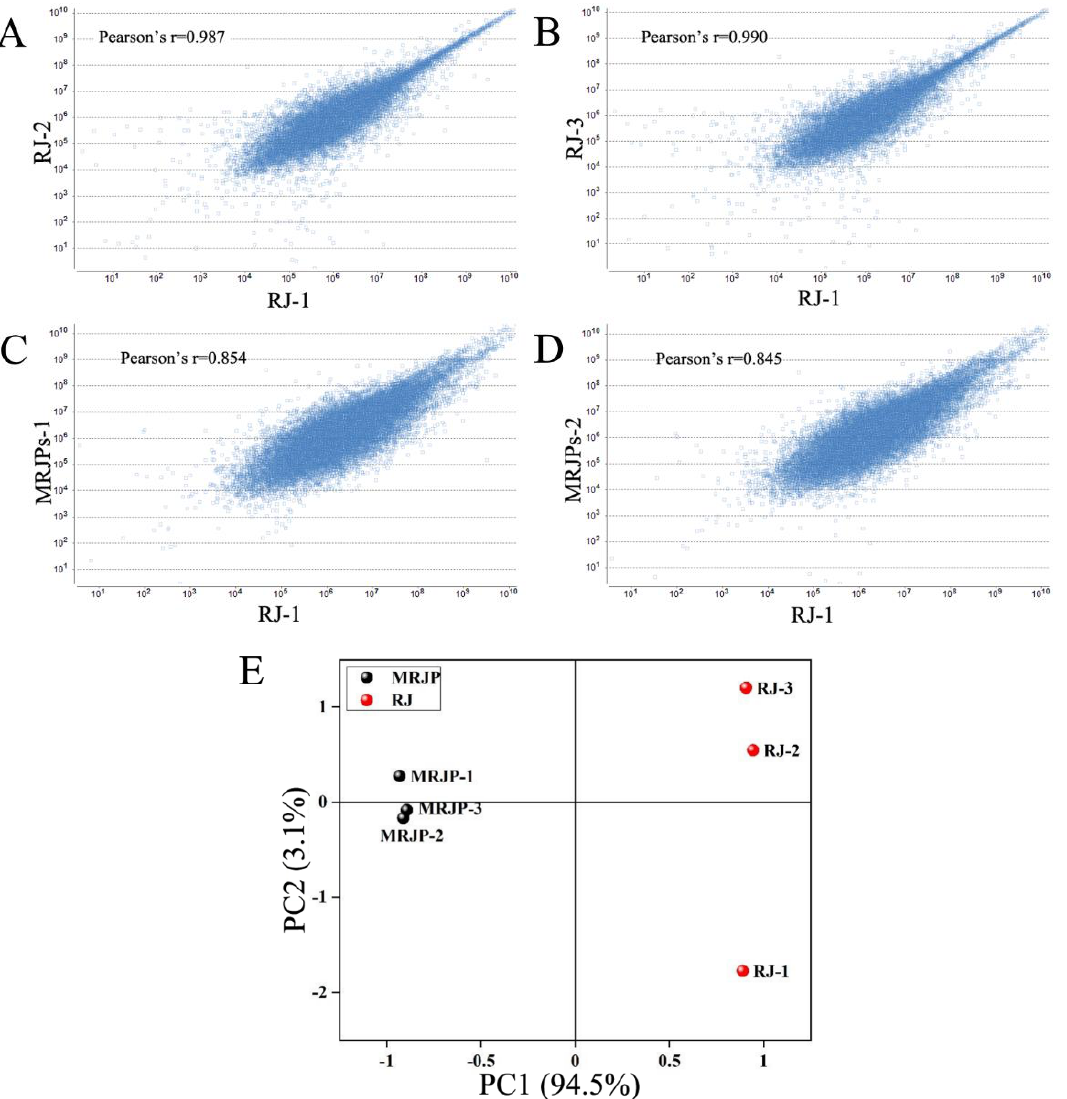
Figure 1. Pearson correlation coefficient and principal component analysis between the royal jelly and MRJPs with three times repeated data. ( A ) Pearson correlation coefficient between RJ-1 and RJ-2; ( B ) Pearson correlation coefficient between RJ-1 and RJ-3; ( C ) Pearson correlation coefficient between RJ-1 and MRJPs-1; ( D ) Pearson correlation coefficient between RJ-1 and MRJPs-2; and ( E ) principal component analysis between RJ and MRJP with three times repeated data.